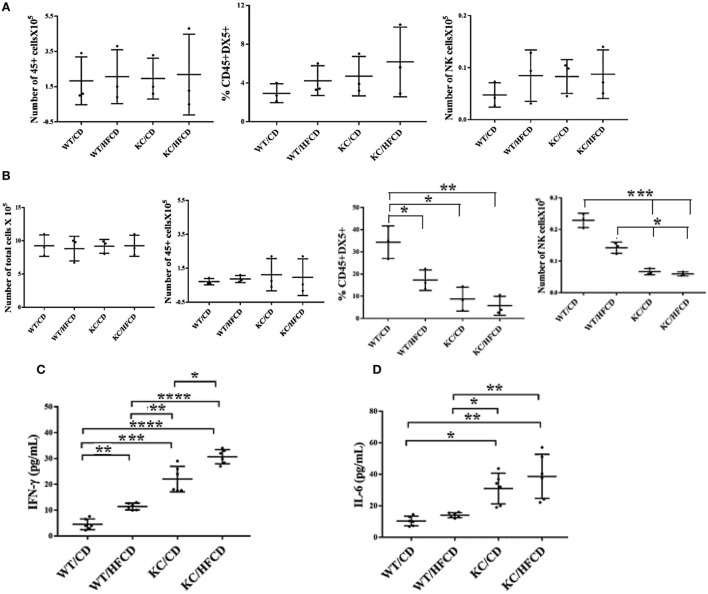
Significant decreases in the numbers of natural killer (NK) cells within gingiva and increases in IFN-γ secretion in KC mice fed with CD and high-fat calorie diet after culture Gingival tissues from four groups of mice shown in the figure were harvested and single-cell suspensions were prepared. Percentages of CD45 and DX5 expressing immune cells within the gingival cells at the time of sacrifice were determined after staining with the respective PE- and FITC-conjugated mouse antibodies and the numbers of CD45+ immune cells, and DX5+ NK cells within CD45+ immune cells were determined for each group of mice. (n = 3) (A). Gingival cells (5 × 105/ml) were cultured with IL-2 (10,000 U/ml) for 7 days after which the total number of cells in each were counted, the percentages of CD45 and DX5 expressing immune cells within the gingival cells were determined and the numbers of CD45+ immune cells and DX5+ NK cells within CD45+ immune cells were determined for each group of mice. (n = 3) (B). Gingival cells were cultured as described in panel (B) and their supernantants were harvested and IFN-γ (C) and IL-6 (D) secretion were determined using specific ELISAs.